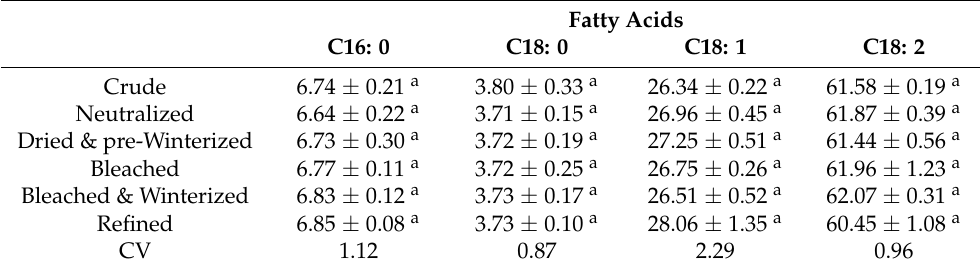
Table 1. Evolution of the content of the fatty acids during the oil-refining process. Means ± standard deviations followed by different superscript letters within the same column are significantly different according to Tukey’s test. All experiments were performed in triplicate. CV: Coefficient of